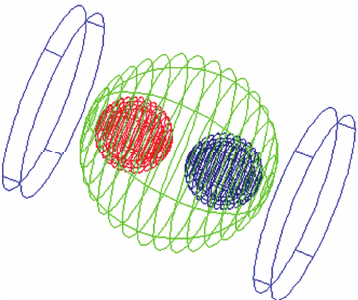
Figure 1: Tissue model with parallel plate electrodes.